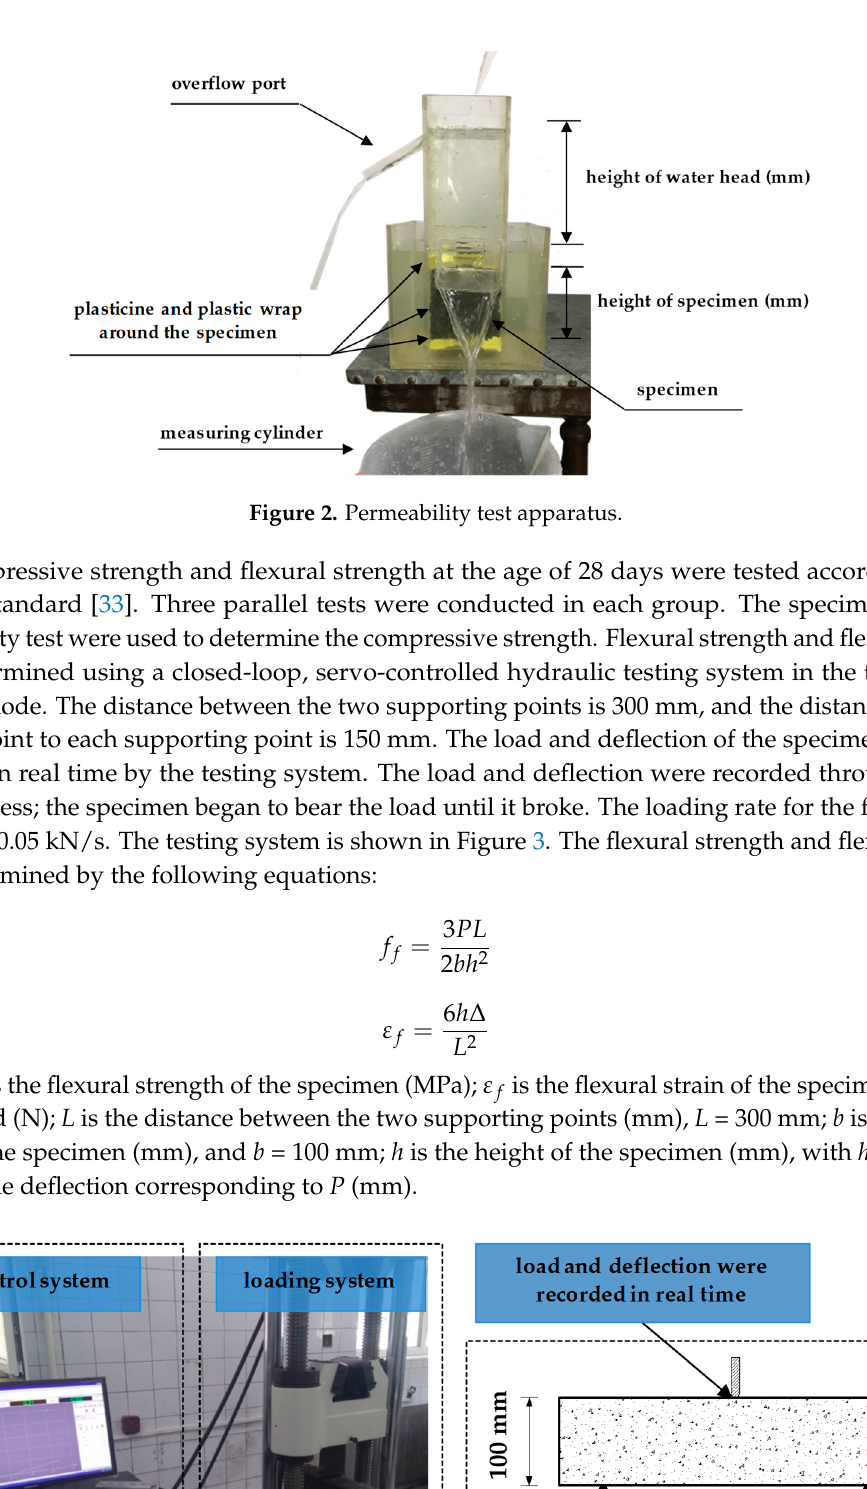
Figure 3. Closed-loop, servo-controlled hydraulic testing system.